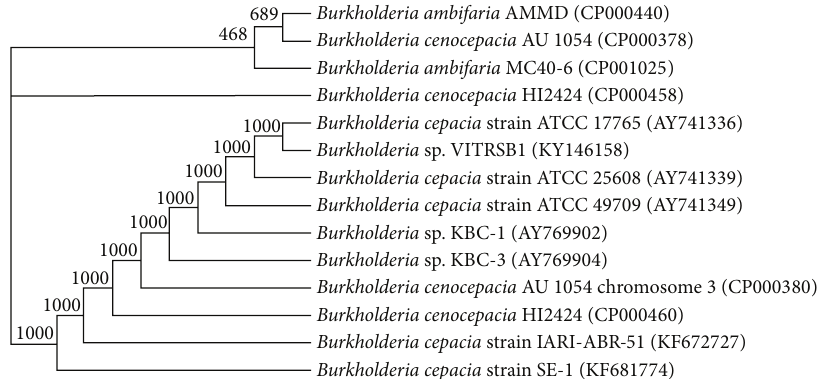
Figure 2: Phylogenetic tree based on 16S rRNA gene sequences displaying the position of the isolate Burkholderia sp. VITRSB1 with a bootstrap value of 1000. Scale bar: